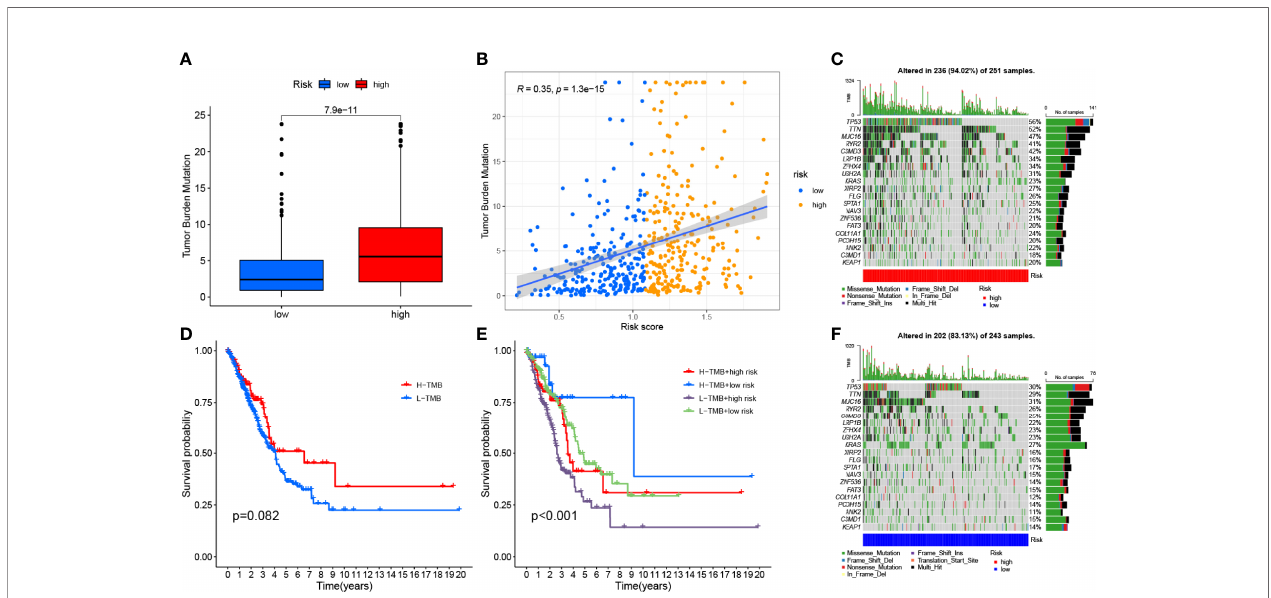
FIGURE 8 | Correlation between risk score and TMB. (A) Differences in TMB between HRG and LRG. (B) Scatterplots depicting the positive correlation between risk scores and TMB. (D) Kaplan – Meier curves of high TMB and low TMB groups. (E) Kaplan – Meier curve strati fi cation of patients according to TMB and risk signature. The oncoPrint was constructed using high risk score (C) and low risk score (F) .